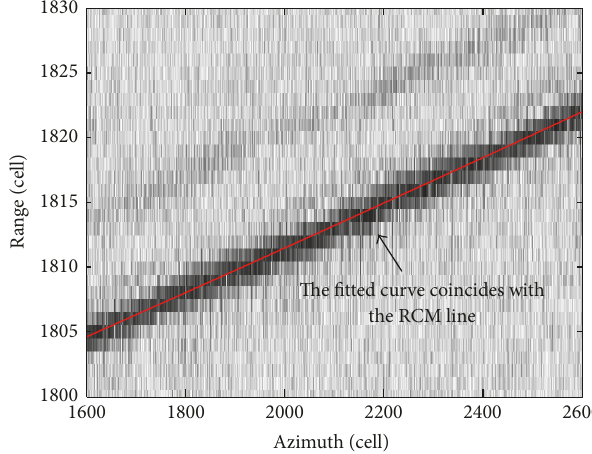
Figure 7: Imaging result based on conventional RCMC (monostatic SAR). The whole image is seriously defocused.